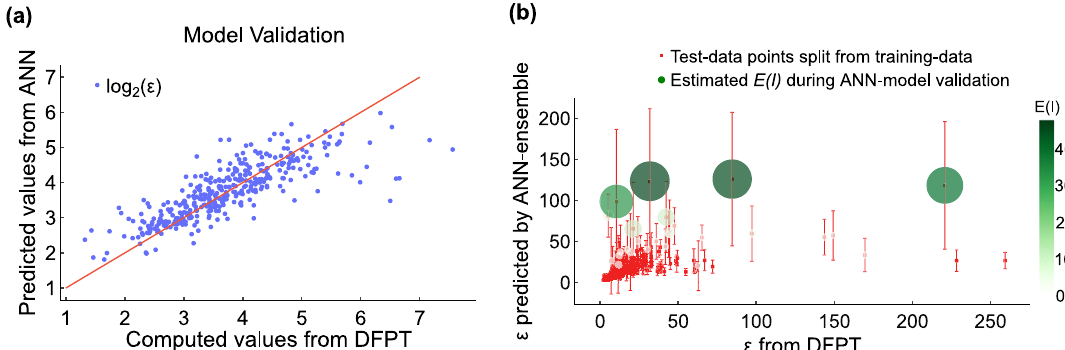
Fig. 3 Results from statistical modeling. a ANN model validation on a test set of 373 materials split from the training-data. We used an ensemble of ANNs to predict a distribution of values for each material. This particular model- fi t plot is taken from a single ANN model that was part of the ensemble in design cycle 2. The 373 materials plotted here were not seen by this particular ANN model at any stage during the training. These predictions are made only for this particular ANN model to show its learning capabilities, and it is not part of the design work fl ow that we created. In the design work fl ow, each ANN model in the ensemble is exposed only to a unique subset of the full MP training- data, excluding 373 randomly chosen materials. Further, in the design work fl ow, this trained ANN model is used to predict the dielectric values of only the search-space materials from OQMD, not the 373 unseen materials from the MP dataset. The model was trained to predict log because the ϵ values were highly non-uniform in the training-data with most of the values below 25, making some of the very large values outliers. A log-scale transformation of ϵ reduced the numerical difference between the largest ϵ value and the median, making the former less of an outlier in ANN modeling. The model fi t shown in this plot has an R 2 score of 70%, and a Spearman's rank correlation of 85%. b This plot shows the predicted ϵ -distributions and corresponding E ( I ) values on the same test dataset consisting of 373 materials split from the training- data. The error bars represent the standard deviation in ANN-ensemble predictions which is quanti fi ed as the uncertainty of ANN modeling. For a clearer perspective, the radius and color of the circles represent the same quantity — the expected improvement, E ( I ), value calculated using the EGO algorithm. A point without an outer circle around it represents a material with a negligible (<10 − 3 ) value for E ( I ). In this fi gure, only 25 materials have an E ( I ) value that is greater than 10 − 3